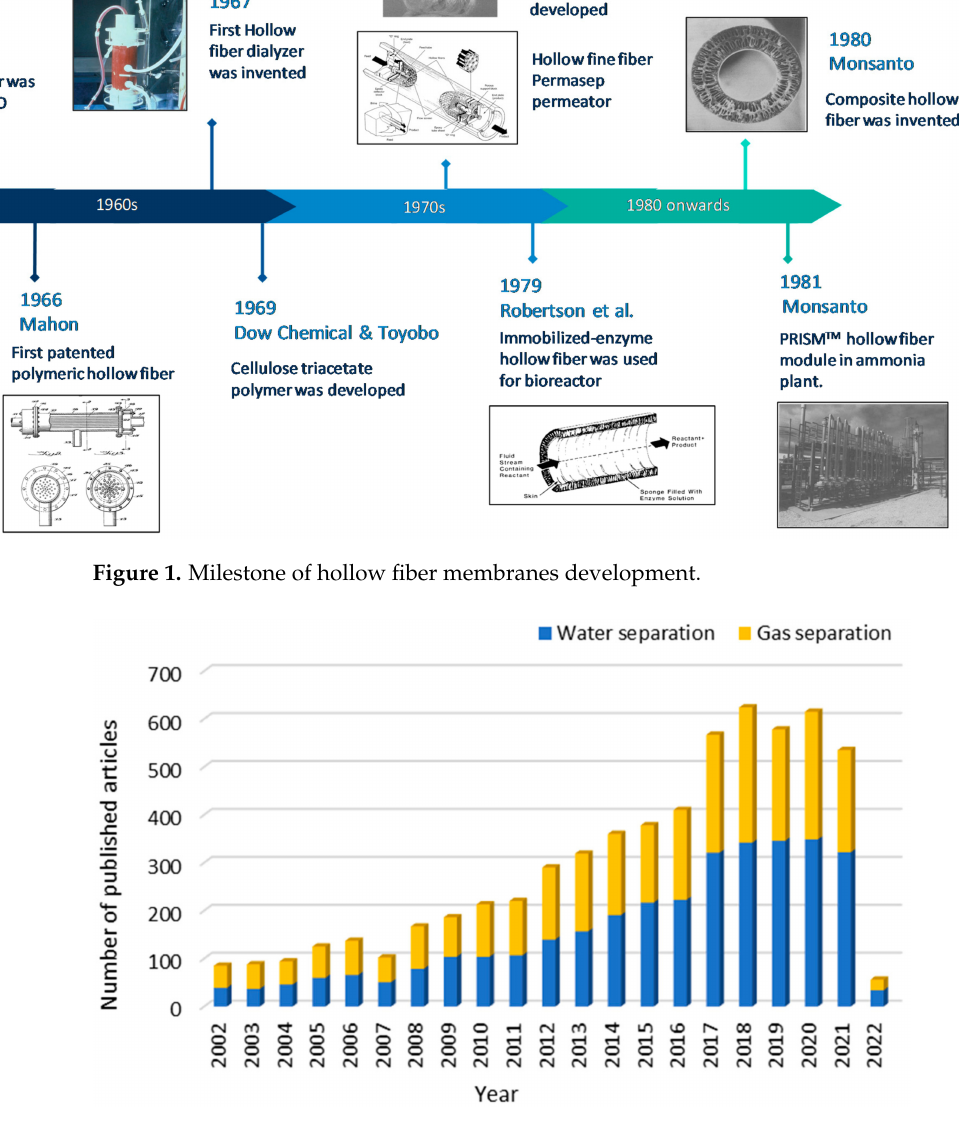
Figure 2. A number of publications in Scopus with the terms “hollow fiber membrane for water separation” and “hollow fiber membrane for gas separation” (accessed on 22 March